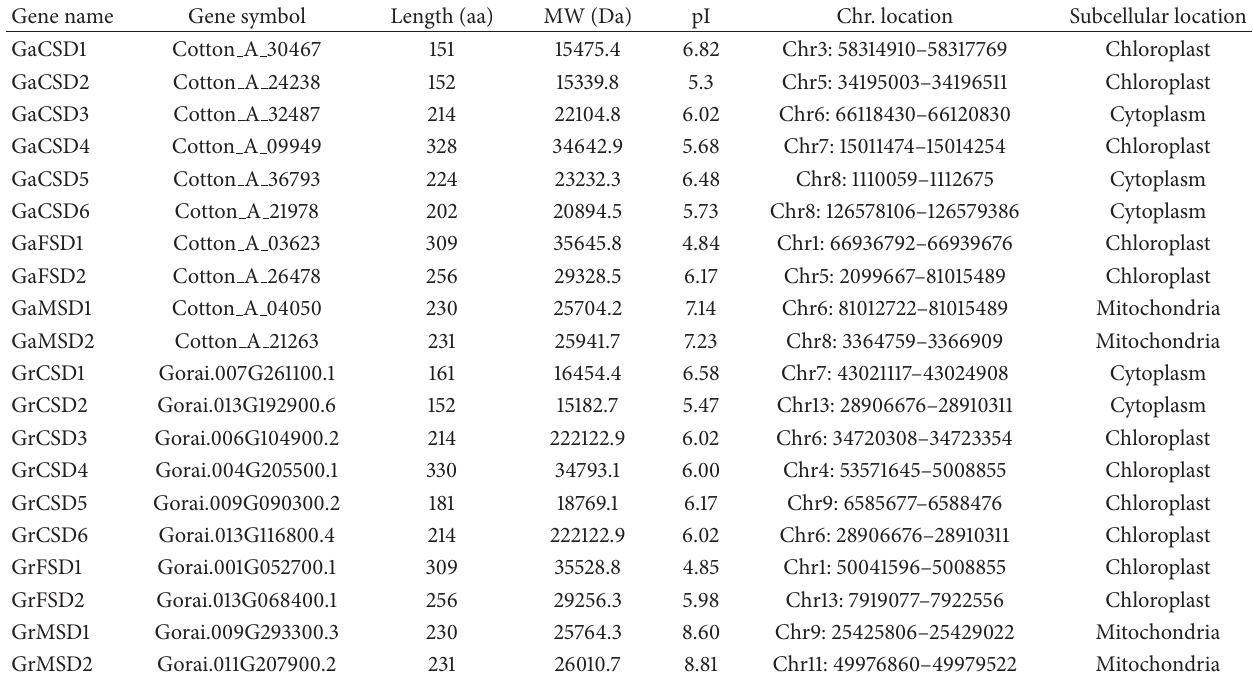
Table 2: Characteristics of SOD genes from G. arboretum and G. raimondii . AA: amino acid; pI: the theoretical isoelectric point of proteins; Mw: the theoretical molecular weight of